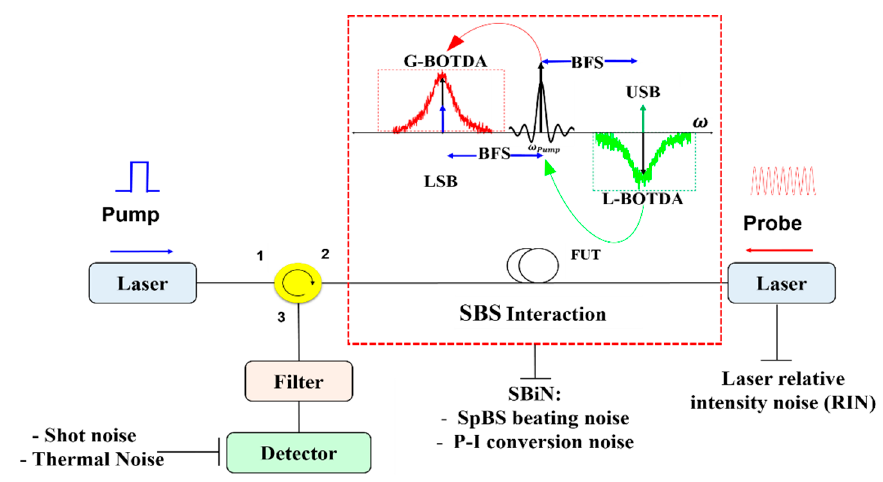
Figure 1. Schematic diagram of the BOTDA system with main noise sources. The inset depicts the SBS interaction between the pump and the probe waves in the frequency domain. FUT: fiber under test, LSB: probe lower frequency sideband, USB: probe upper frequency sideband, BFS: Brillouin frequency shift. The small blue and green arrows within the G-BOTDA and L-BOTDA band describe the spontaneous Stokes and anti-Stokes Brillouin component, respectively.